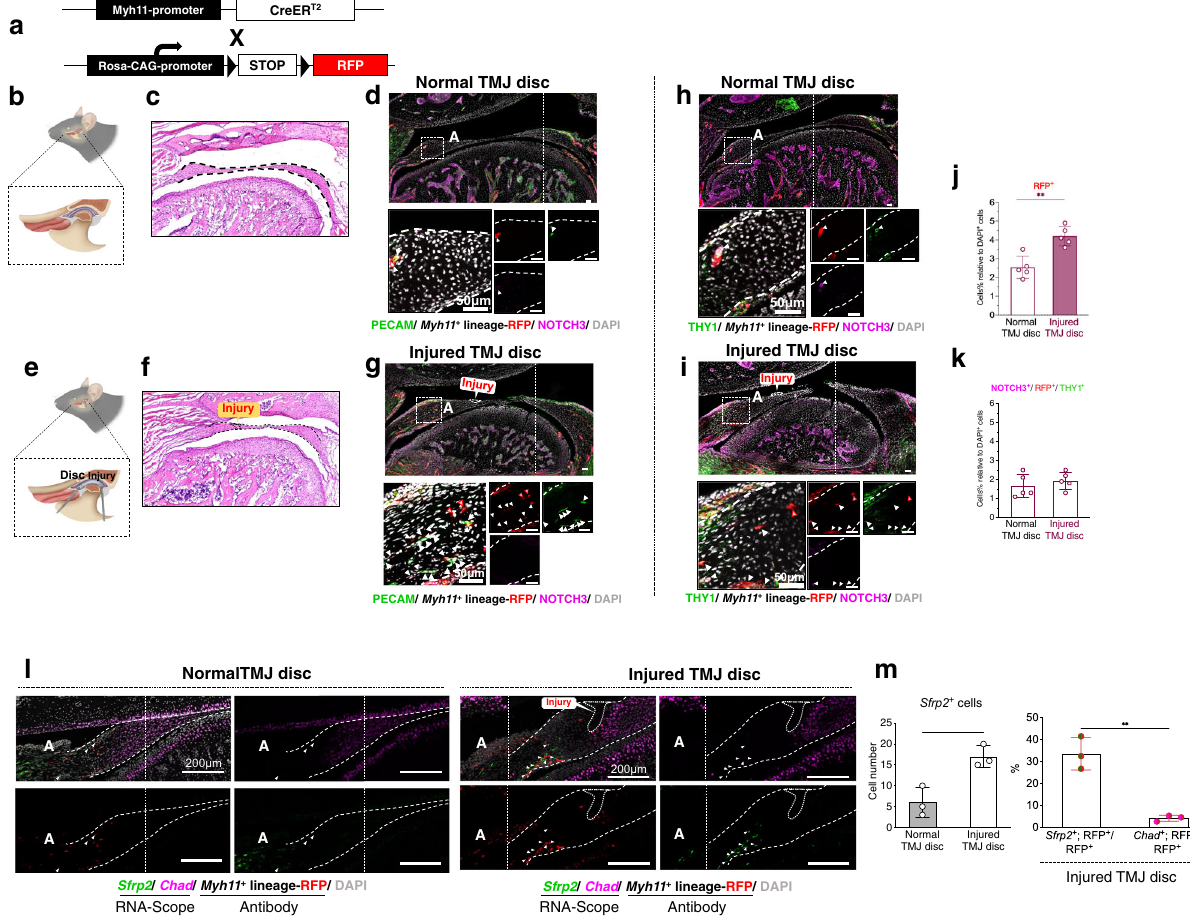
Fig. 8 | Muralcellstransform toward non-chondrogenic fi broblasts inTMJdisc injury. a Schematic diagram of the mating strategy for generating Myh11-Cre ER ; Tm fl /- mice. b Schematic diagram of the normal anatomical structure of mice TMJ disc. c H&Estainingofnormaldiscs.Dottedlines:discboundary. N =5independent animals.Scalebar:200 μ m. d Immuno fl uorescencestainingofnormaldiscs.Green: PECAM-1; Magenta: NOTCH3; red: Myh11 + lineage-RFP; blue: DAPI. Triangular arrows: Myh11 + lineage;long-tailedarrows:PECAM-1 + cells.A:anteriorband;dotted lines: disc boundary. N =5 independent animals. Scale bar: 50 μ m. e Schematic diagram of the anatomical structure of injured discs in mice. f H&E staining of injured discs. Dotted lines: disc boundary. N =5 independent animals. Scale bar: 200 μ m. g Immuno fl uorescence staining of injured discs. Green: PECAM-1; Magenta: NOTCH3; red: Myh11 + lineage-RFP; blue: DAPI. White triangular arrows: Myh11 + cell lineage; white long-tail arrows: PECAM-1 + cells; red triangular arrows: RFP + /NOTCH3 - . A: anterior band, dotted lines: disc boundary. N =5 independent animals. Scale bar: 50 μ m. h Immuno fl uorescence staining of normal discs. Green: THY1; Magenta: NOTCH3; red: Myh11 + lineage-RFP; blue: DAPI. White triangular